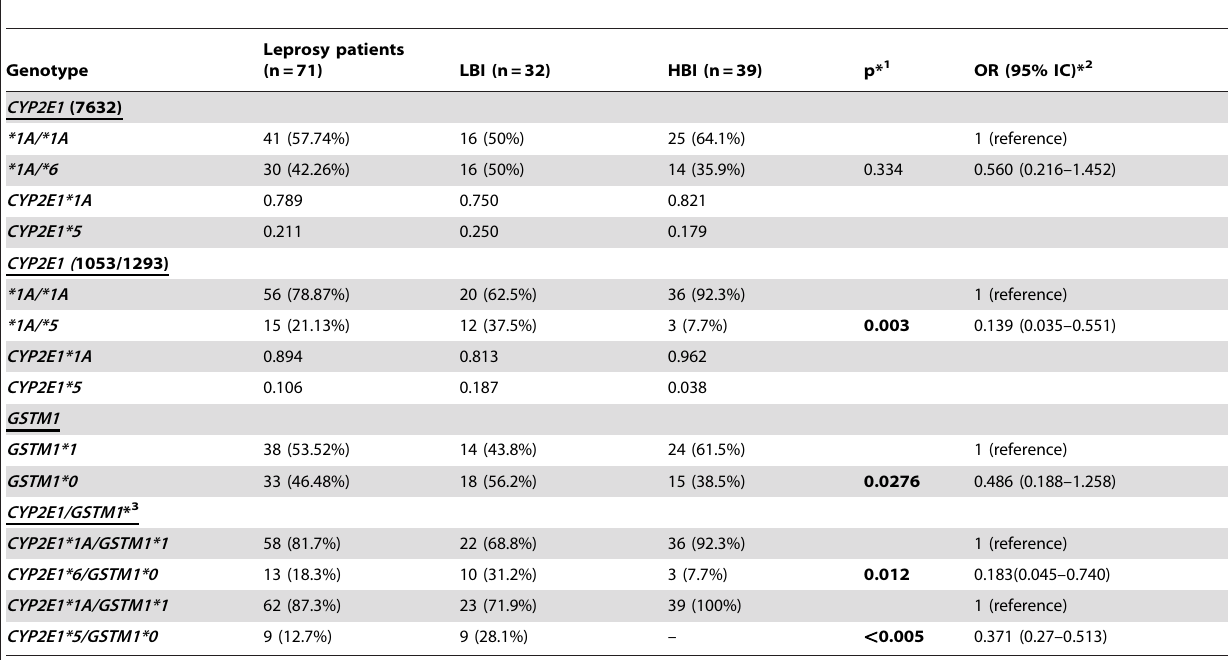
Table 3. Combined and isolated genotypic distribution of CYP2E1 gene (SNPs 1053T . C, 1293C . G and 7632T . A), and deletion